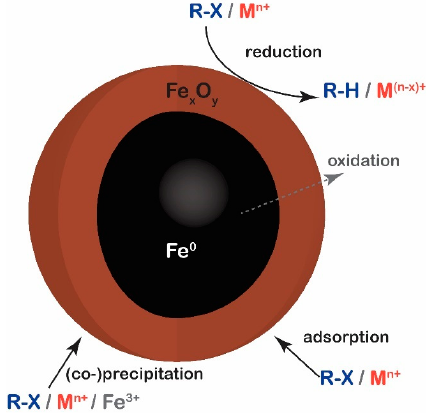
Figure 8. Sketch of a core–shell iron based nanoparticle for water remediation.